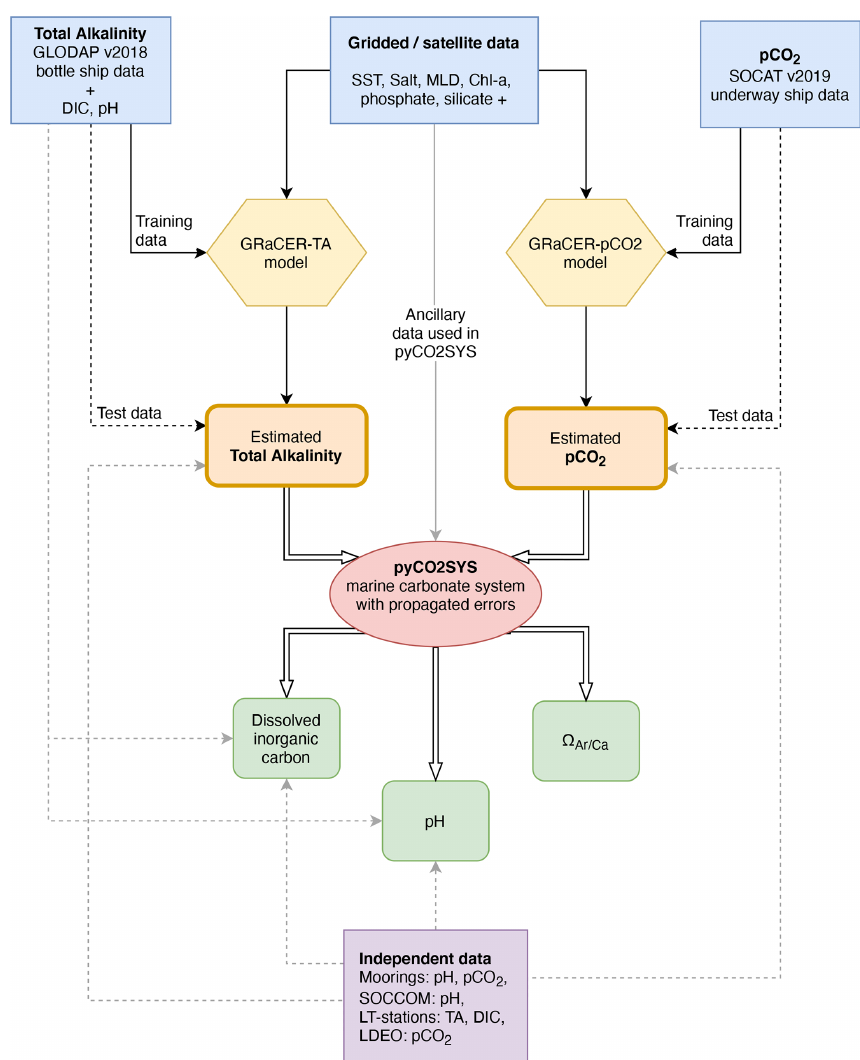
Figure 1. Schematic flow diagram showing the three steps required to reconstruct the surface ocean carbonate system. In the first step (yellow hexagons), the GRaCER (Geospatial Random Cluster Ensemble regression) method is used to develop statistical models for the observed TA (left) and p CO 2 (right) fields. In the second step (orange rectangles), these statistical models are used to extrapolate these two parameters over time and space using ancillary observations, primarily stemming from satellite observations. In the third step (red oval), the interpolated and extrapolated TA and p CO 2 fields are then used to compute the remaining parameters of the surface ocean carbonate system, namely DIC, pH, and the saturation state of seawater with regard to mineral CaCO 3 , (cid:127) . The output of steps two and three is the OceanSODA-ETHZ product. Also shown are the various data sets and data flows used in this study. The different lines indicate whether data are used for training (solid lines), testing (dashed lines), or output with an estimate of uncertainty, where independent test data are shown with gray dashed lines. The gridded/satellite data are summarized in Table 1. Independent test data are shown by the purple box. pyCO2SYS is the software used to solve the marine carbonate system and propagate uncertainties (Humphreys et al.,